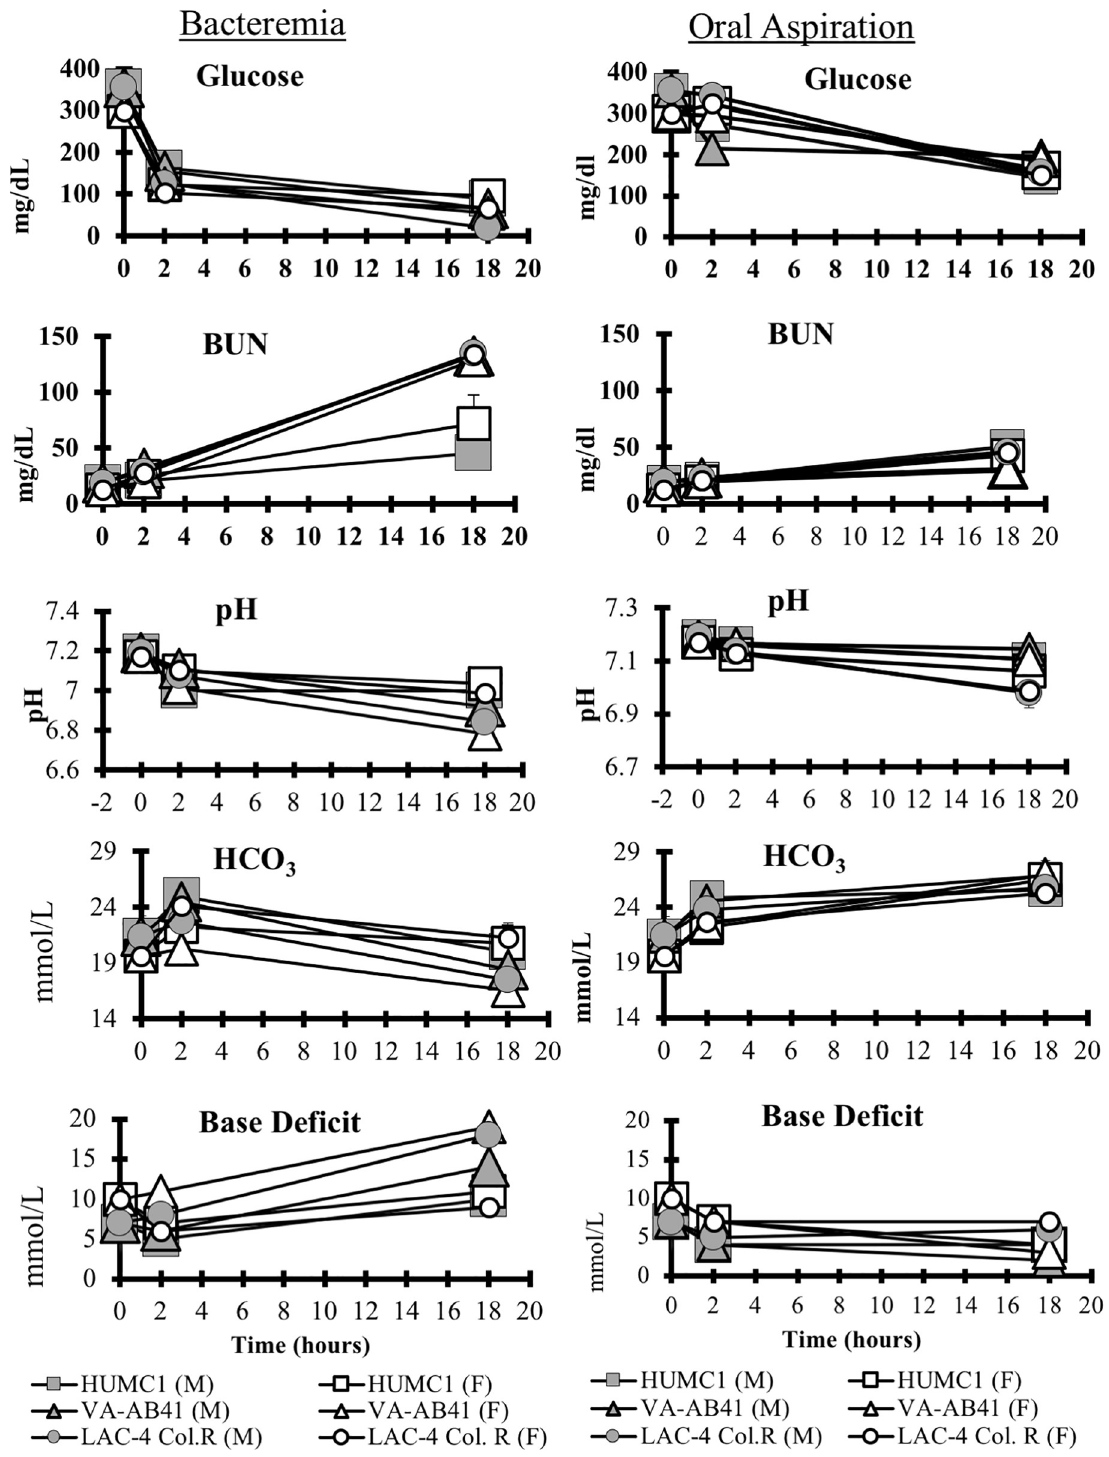
Fig 5. Sepsis biomarkers. Blood samples were collected from healthy and infected mice at 2 and 18 hours post-infection. BUN = blood urea nitrogen, a marker of renal function. Base excess = difference between measured and predicted serum bicarbonate. Falling base excess is consistent with a metabolic acidosis due to sepsis, while rising base deficit is consistent with respiratory failure, trapping CO2 in the blood, resulting in increased bicarbonate and carbonic acid levels. BUN was significantly increased at 18 hours for all infecting strains in the bacteremia model but only HUMC1 and VA-AB41 in the OA model (P < 0.05). Bicarbonate was significantly increased in the OA